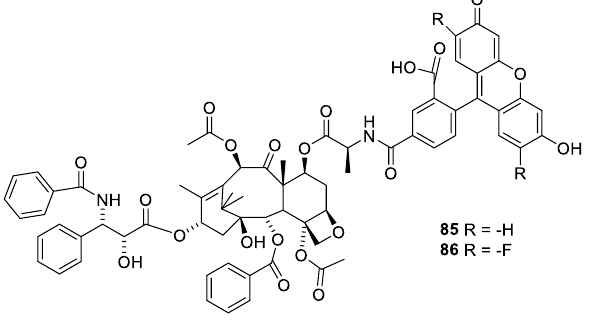
Figure 22. Britaxel-5 ( 81 ), -6 ( 82 ), -7 ( 83 ) and -5 ( 84 ) [77,78].